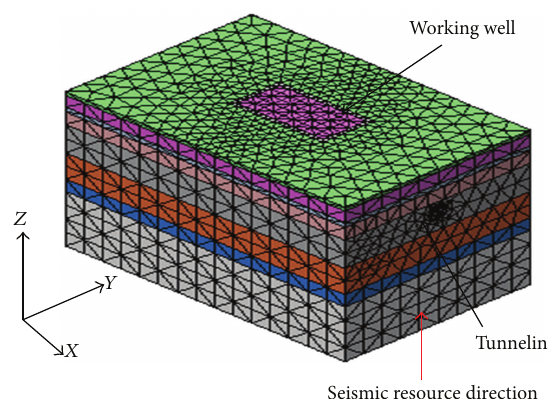
Figure 3: A representation of the general numerical modelling scheme